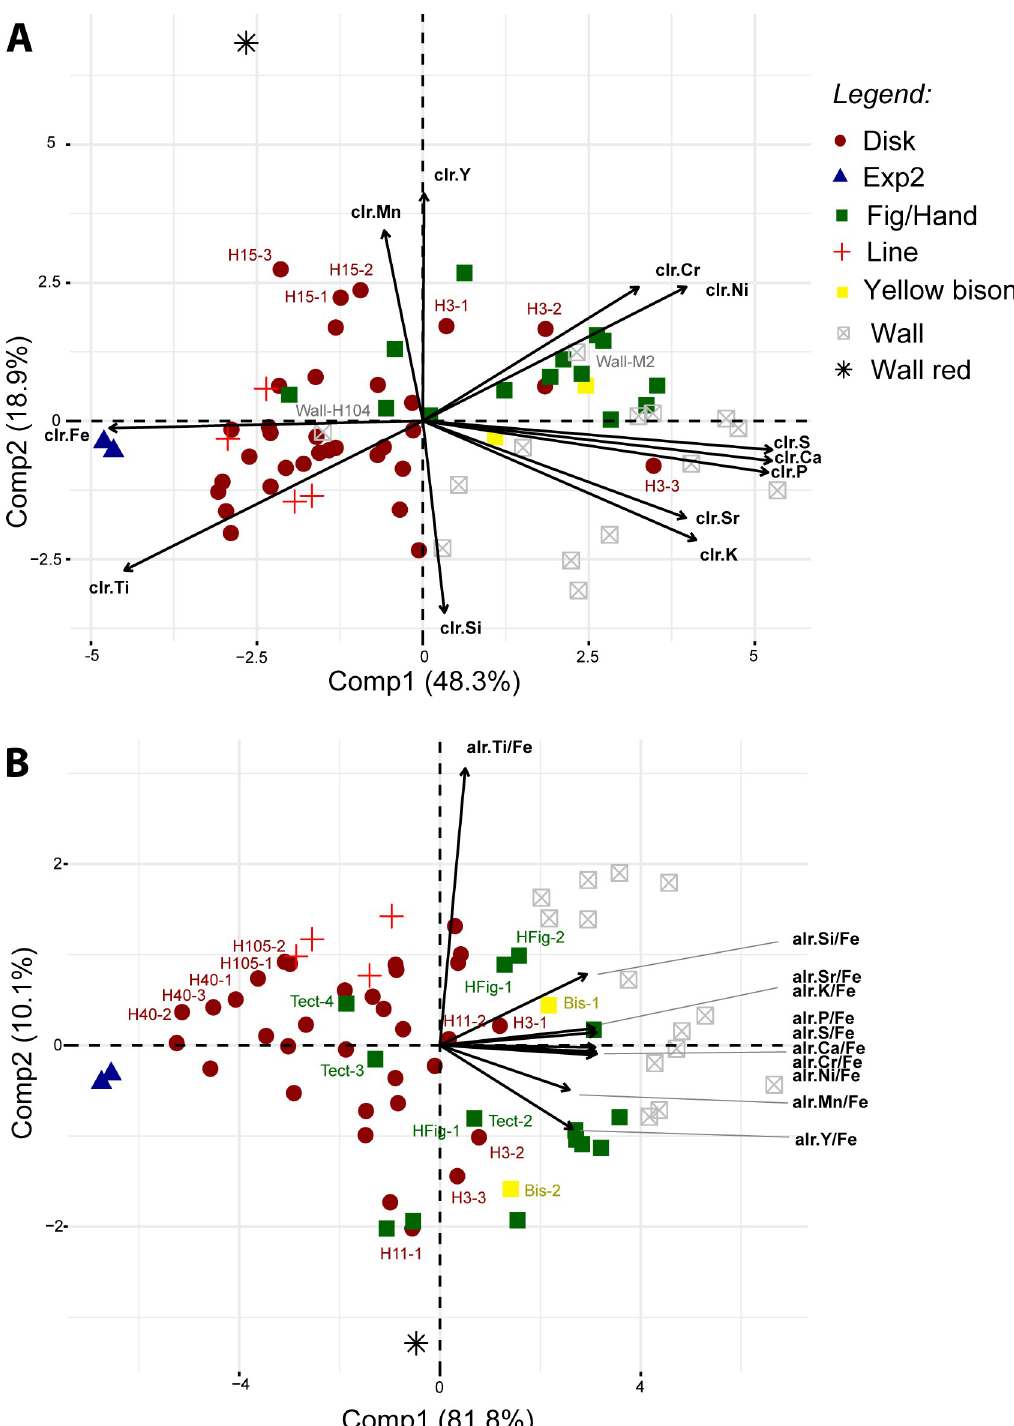
Fig 9. Results of PCAa and PCAc of clr coordinates (A) and alr Fe-ratios (B) of netto counts (peak areas). On the right: coordinates of individuals; on the left: coordinates of variables.